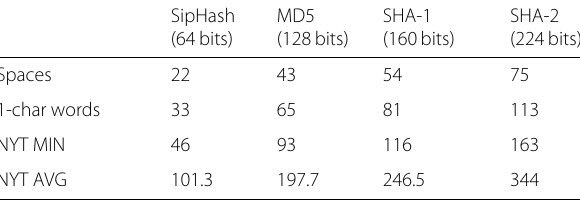
Table 3 Text length required to embed a